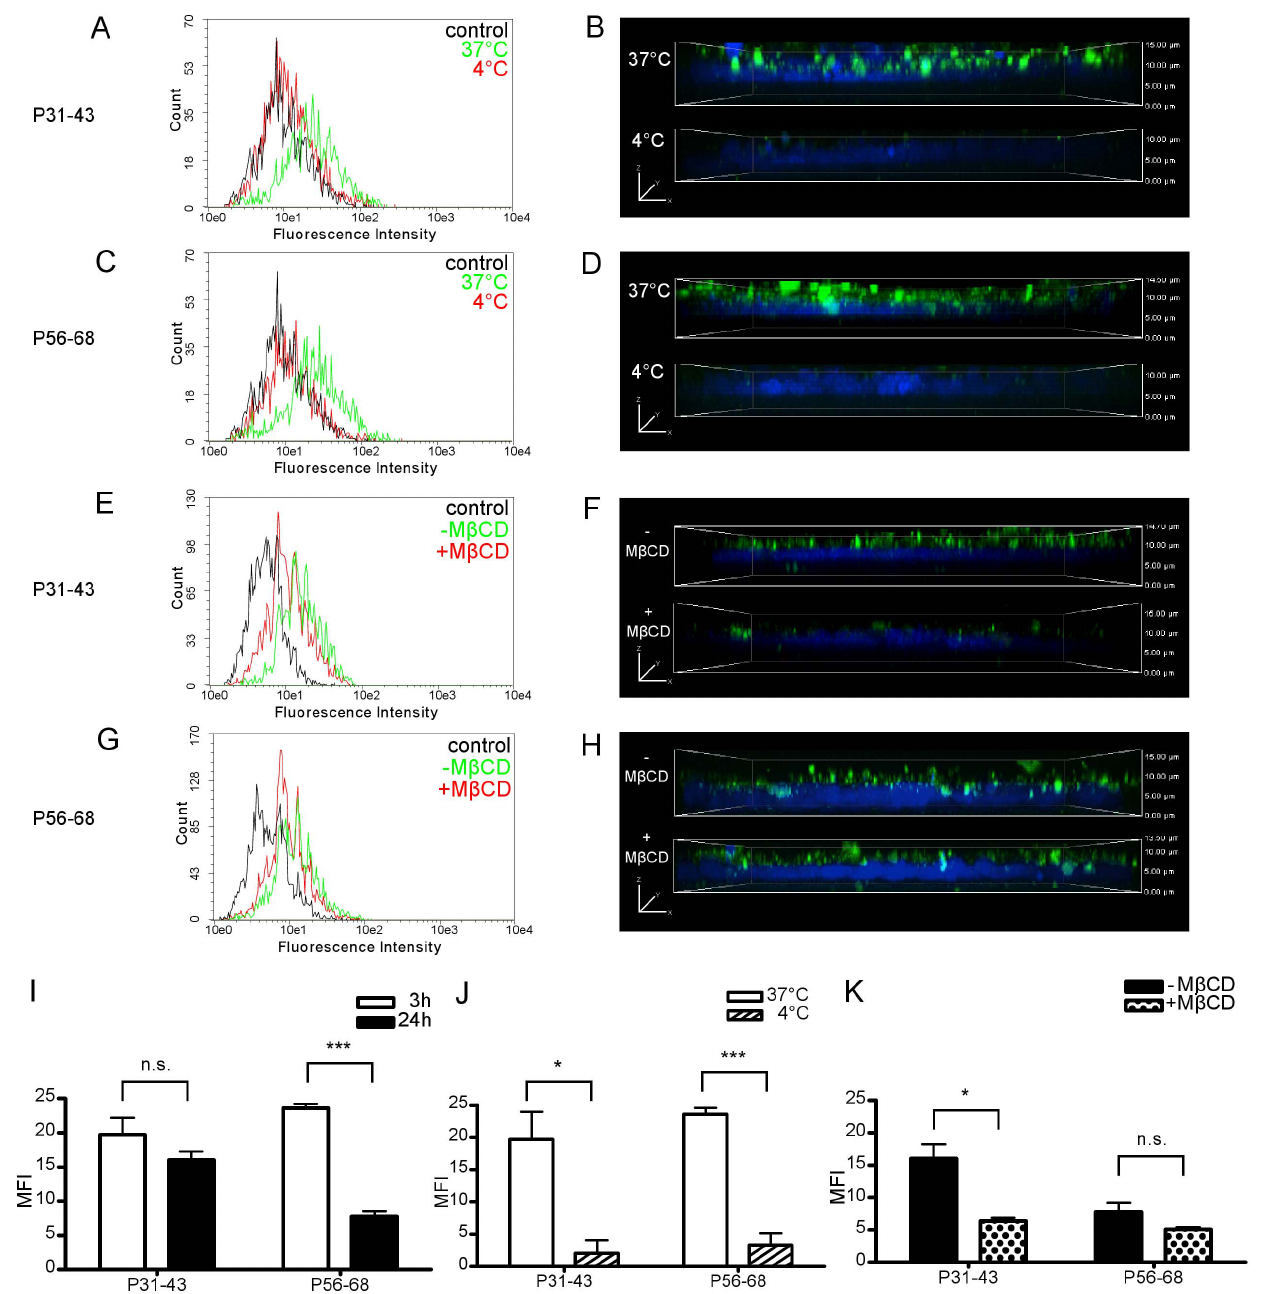
Figure 3. Cellular uptake of fluorescence signal in Caco–2 cells incubated with fluorescence labeled GP. Flow cyctometry (A + C) and confocal microscopy (B + D) of Caco–2 cells after 3 h incubation with P31–43 (A + B) and P56–68 (C + D) at 37 ˚ C and 4 ˚ C. Flow cyctometry (E + G) and confocal microscopy (F + H) of Caco–2 cells after 24 h incubation with P31–43 (E + F) and P56–68 (G + H) with ( + M b CD) and without methyl- b -cyclodextrin ( 2 M b CD). To detect autofluorescence of Caco–2 cells, non-treated cells were analysed and used as controls. Mean fluorescence intensity (MFI) of cells analysed by flow cytometry (I-K): Comparison of MFI of Caco–2 cells after 3 h and 24 h incubation with P31–43 and P56–68 (I). Comparison of MFI of Caco–2 cells after 3 h incubation with P31–43 and P56–68 at 37 ˚ C and 4 ˚ C (J). Comparison of MFI of Caco–2 cells after 24 h incubation with P31–43 and P56–68 with and without M b CD (K). Results are shown as mean ¡ SD; *p , 0.05, ***p , 0.005.